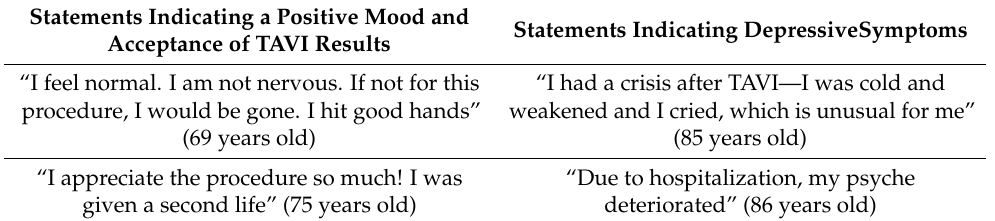
Table 4. Examples of patients’ statements about their mood after TAVI based on a psychological narrative interview and thematic